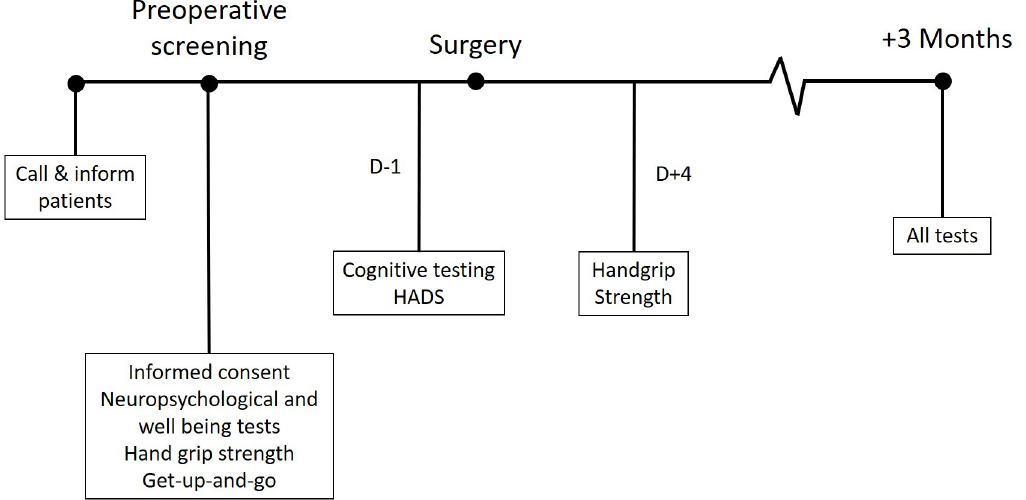
Fig 1. Data collection timeline. A timeline of data collection per patient. D-1 = one day before surgery; D+4 = four days after surgery; HADS = Hospital Anxiety and Depression Scale.